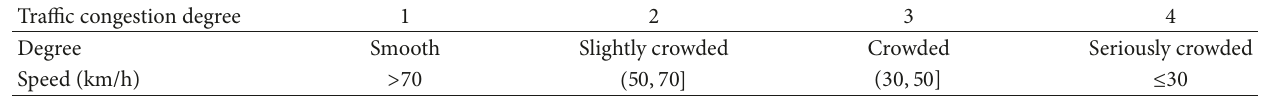
Table 5: Crowded classification standard.